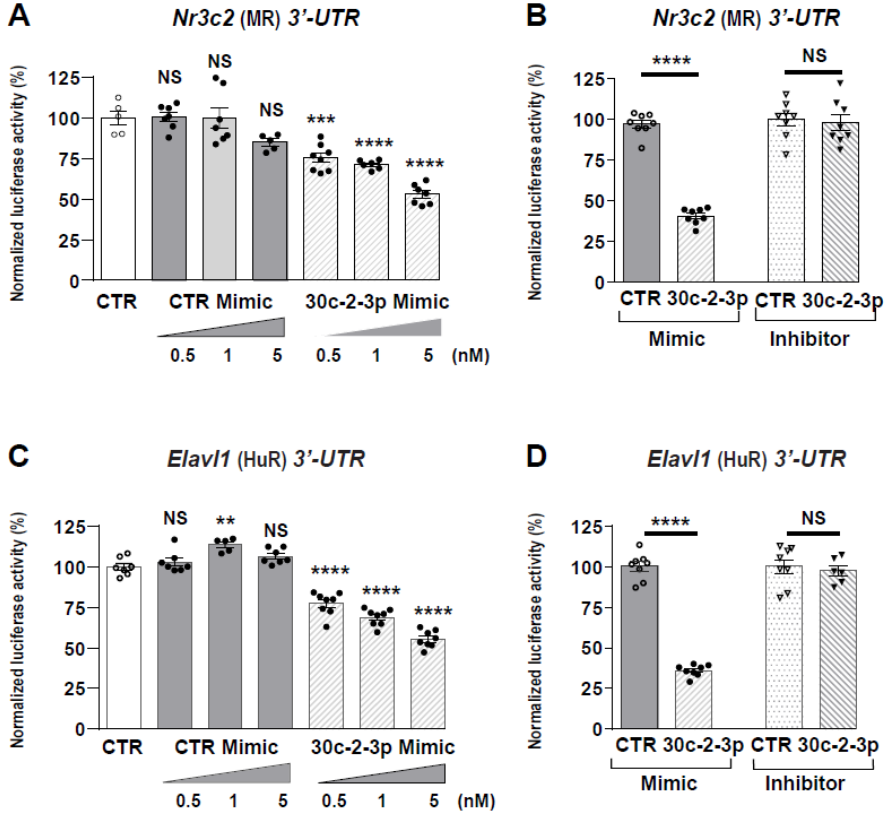
Figure 3. miR-30c-2-3p functionally interacts with Nr3c2 (MR) and Elavl1 (HuR) 3 (cid:48) -UTR. The murine Nr3c2 (MR) and Elavl1 (HuR) 3 (cid:48) -UTR were cloned downstream of the pMIR-REPORT luciferase vector. ( A , C ) HEK 293T cells were transiently transfected, as described in Materials and Methods Section, with pMIR-luciferase plasmid (pMIR-Luc) fused to Nr3c2 (MR) or Elavl1 (HuR) 3 (cid:48) -UTR (40 ng/well of 96-well plates) and incubated with increasing concentrations (0.5, 1, 5 nM) of negative control Mimics (CTR Mimic) or 30c-2-3p Mimics. Luciferase activities were measured 24 h after transfection and normalized to β -galactosidase activities. ( B , D ) HEK 293T cells were transiently transfected with pMIR-Luc fused to Nr3c2 (MR) or Elavl1 (HuR) 3 (cid:48) -UTR (40 ng/well of 96-well plates) and 10 nM of control (CTR) or 30c-2-3p Mimics and with 10 nM of control (CTR) or 30c-2-3p Inhibitors. Luciferase activities were measured 24 h after transfection and normalized to β -galactosidase activities. Data are means ± SEMs ( n = 8). NS = not significant, ** p <0.01, *** p <0.001, **** p <0.0001 compared to luciferase activity of pMIR-Luc fused to Nr3c2 (MR) or Elavl1 (HuR) 3 (cid:48) -UTR without Mimics ( A , C ) or with CTR Mimics or CTR Inhibitors ( B , D ), arbitrarily set at